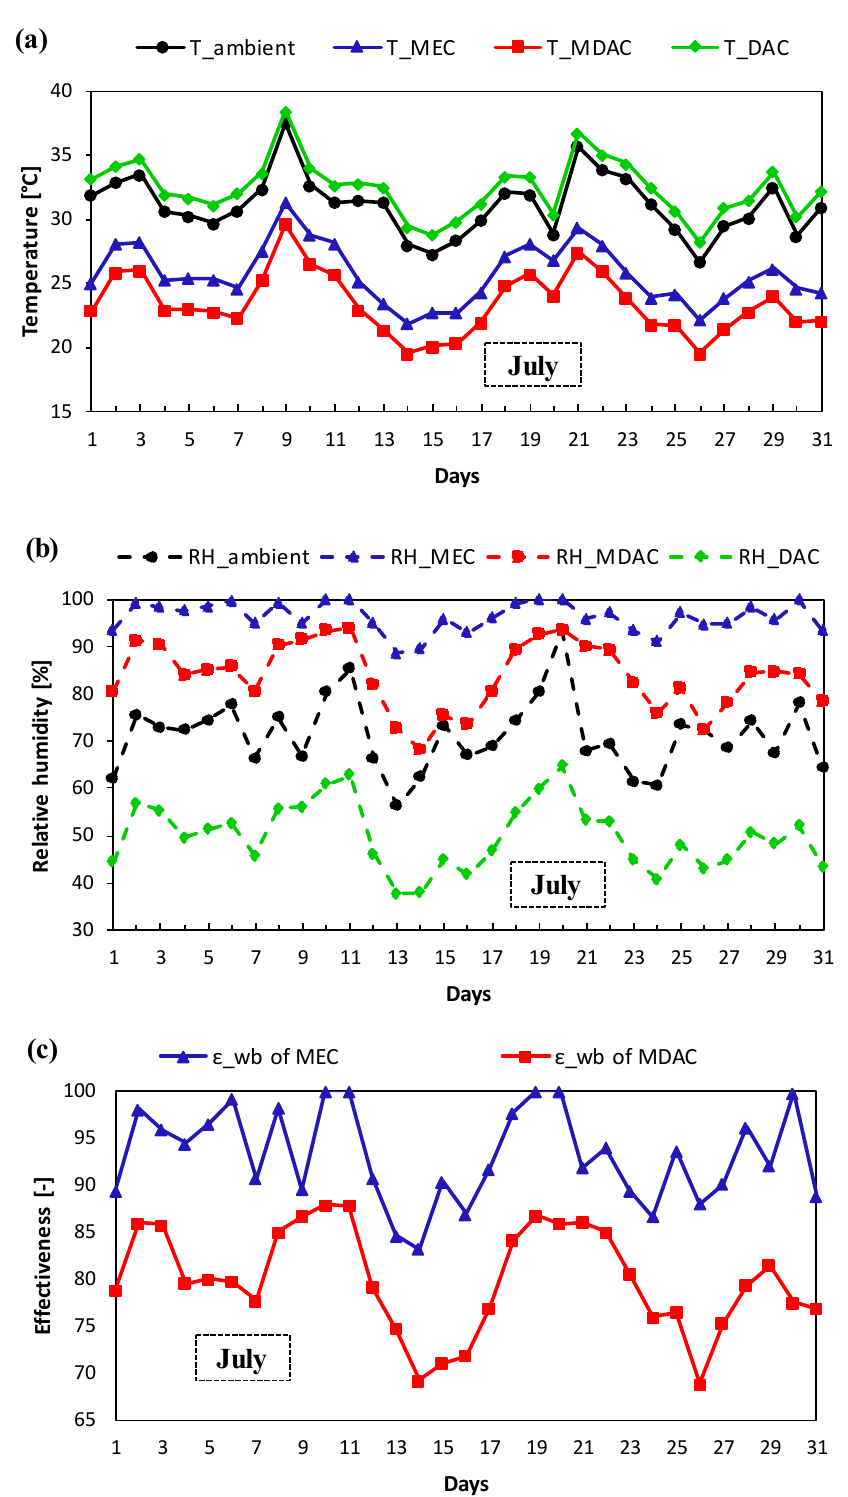
Figure 5. Analysis of proposed AC system options on daily basis for July for Multan (Pakistan); ( a ) outlet temperature; ( b ) relative humidity; and ( c ) effectiveness.